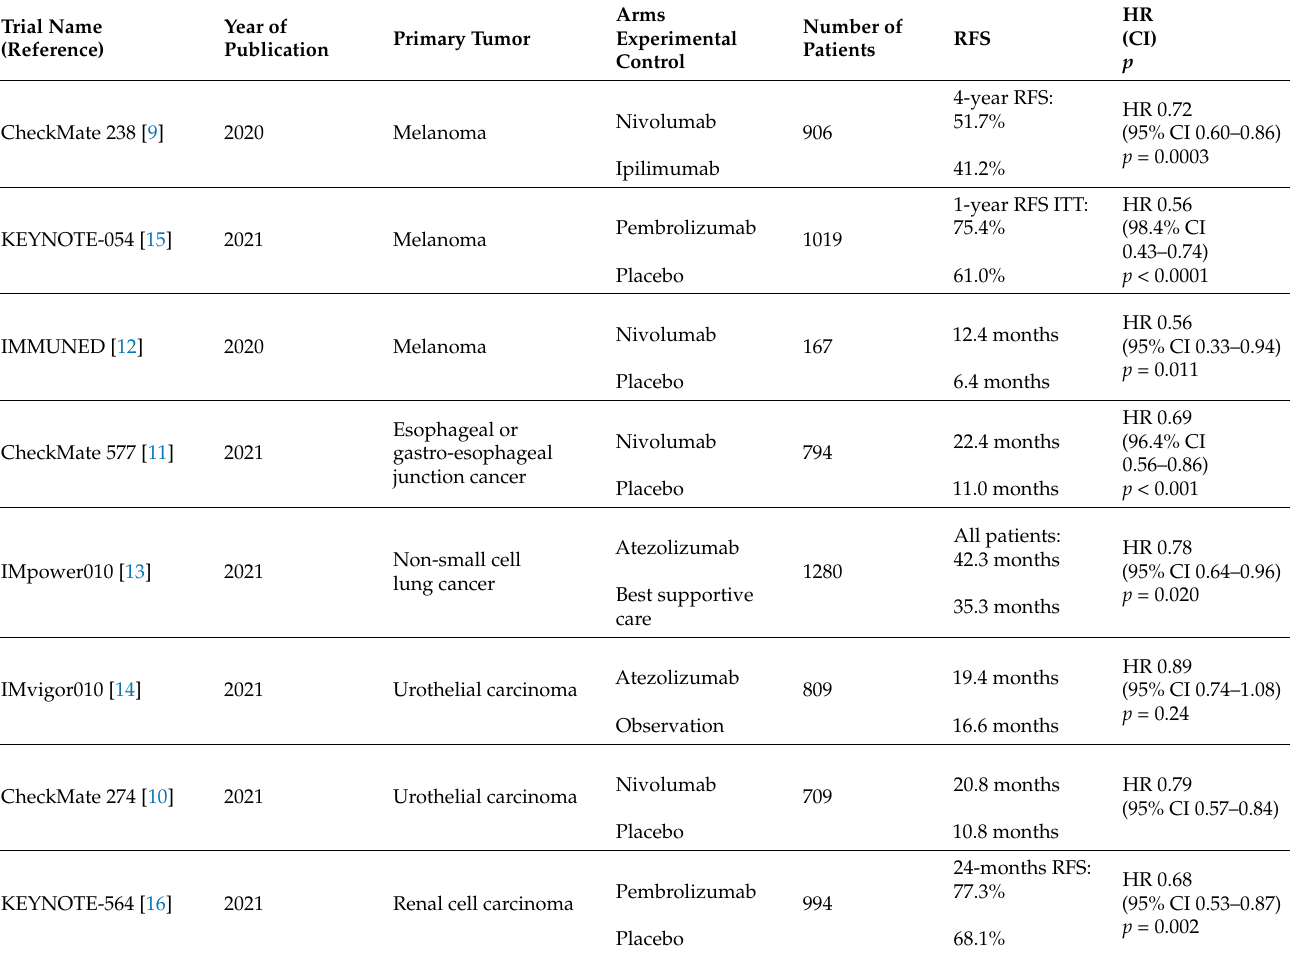
Figure 3 . Forest plot of comparison between adjuvant PD-1 and PD-L1 inhibitors versus control (placebo/ipilimumab/observation/best supportive care) in cancer patients; the outcome of interest was relapse-free survival (RFS) in the intention-to-treat population. Abbreviations: CI: confidence interval; ES: effect size; and W: weight.